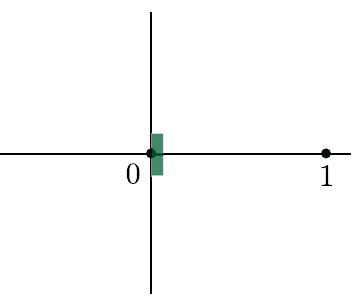
Figure 7 . The smearing region on the z and (cid:22) z planes is the shaded rectangle near the origin. The Regge limit is z; (cid:22) z !